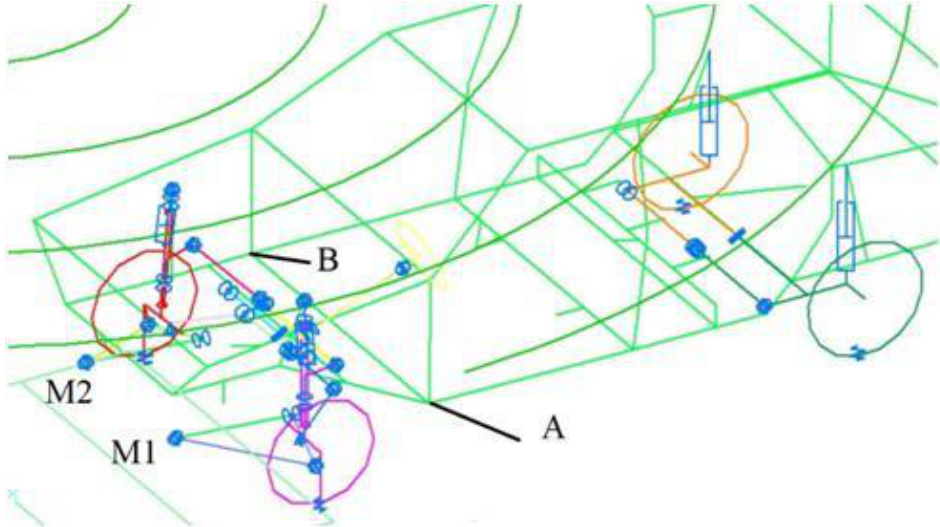
Figure 5. The calculation scheme of a car. A and B is the points whose reference motion is defined. M1 and M2 are the links where the control torques are